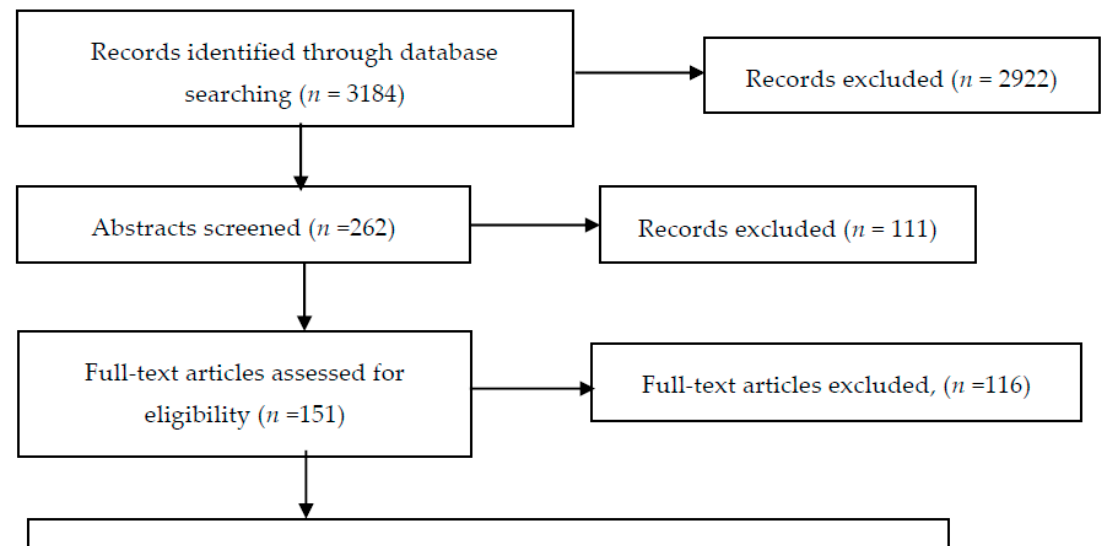
Figure 1. Flow diagram of search.